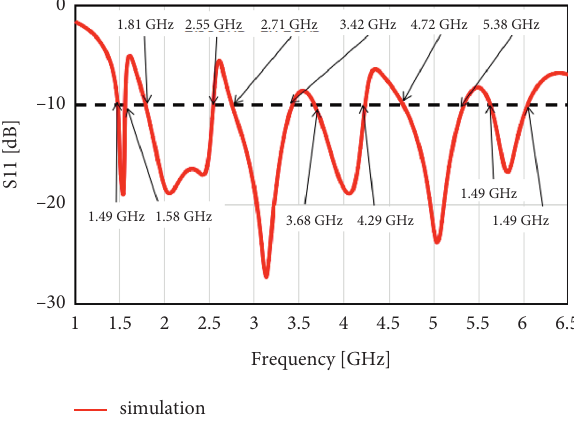
Figure 5: Antenna’s return loss graph. Table 2: Antenna’s commercial communication frequency